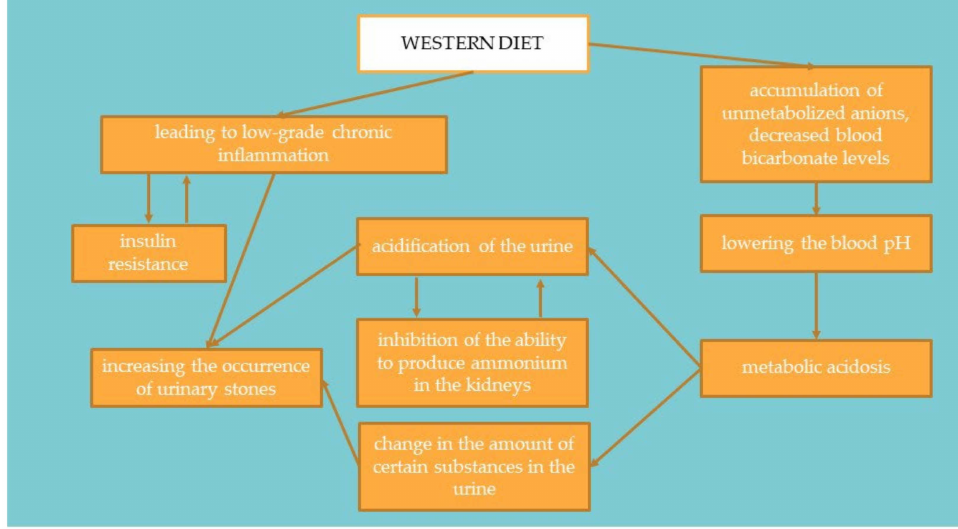
Figure 4. Linking the Western diet with insulin resistance and the occurrence of